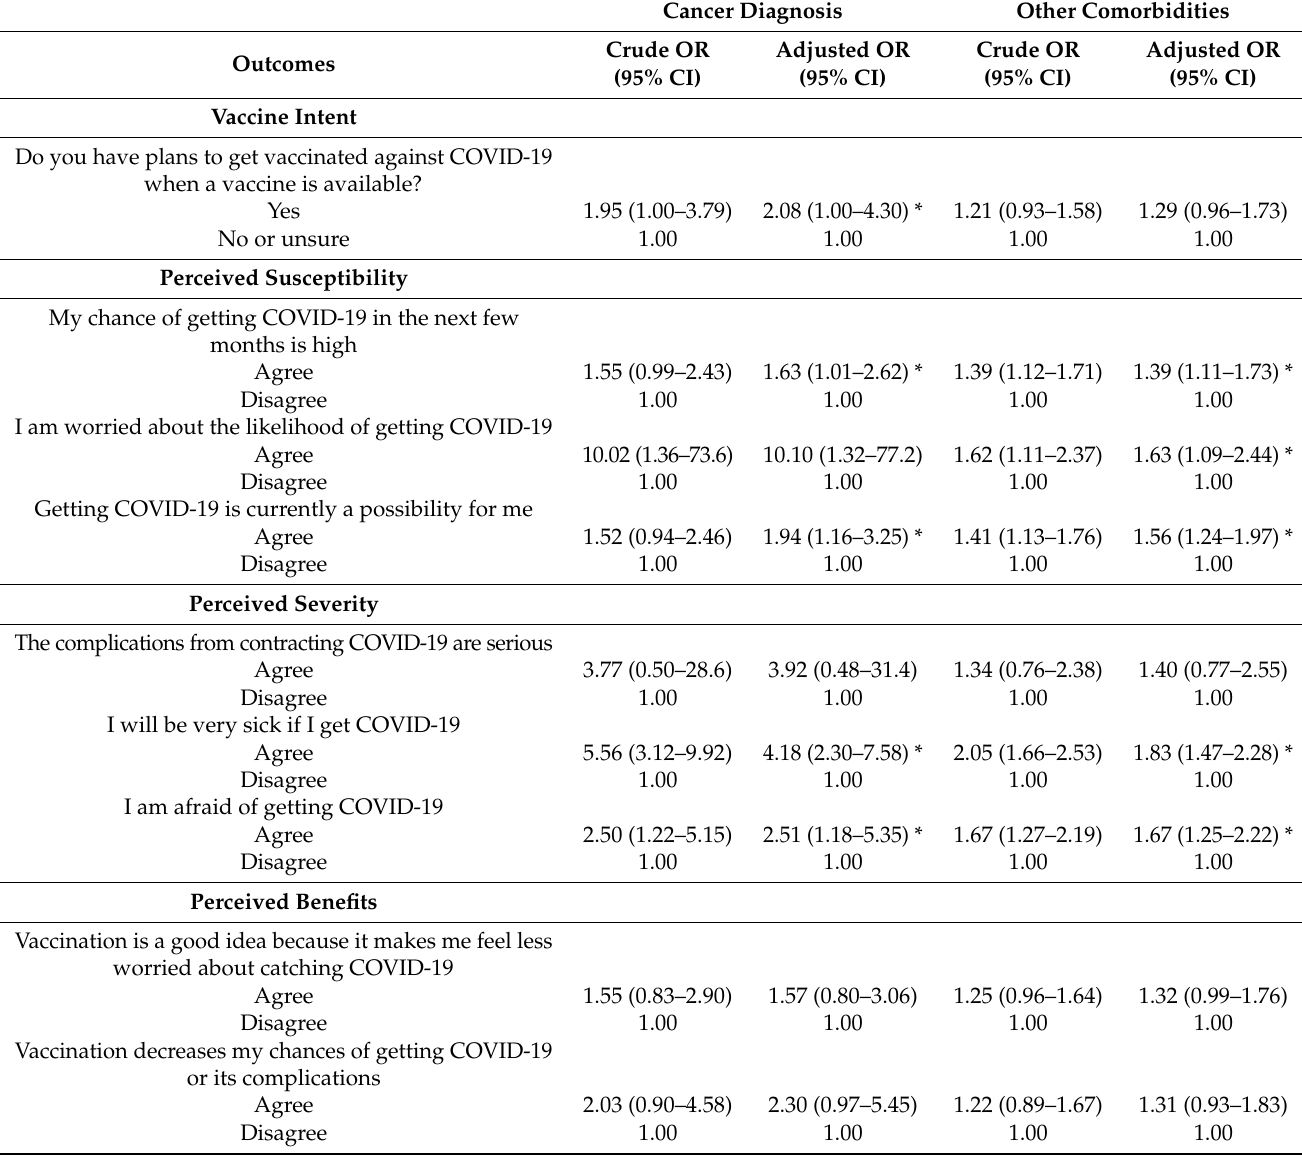
Table 3. COVID-19 vaccine intent and predictors by disease status using logistic